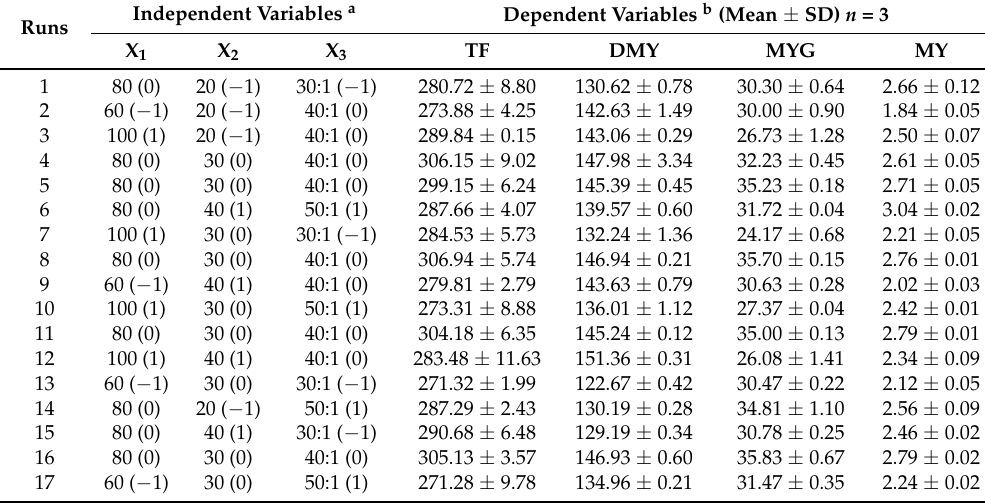
Table 1. Experimental values of the response variables for the Box–Behnken design